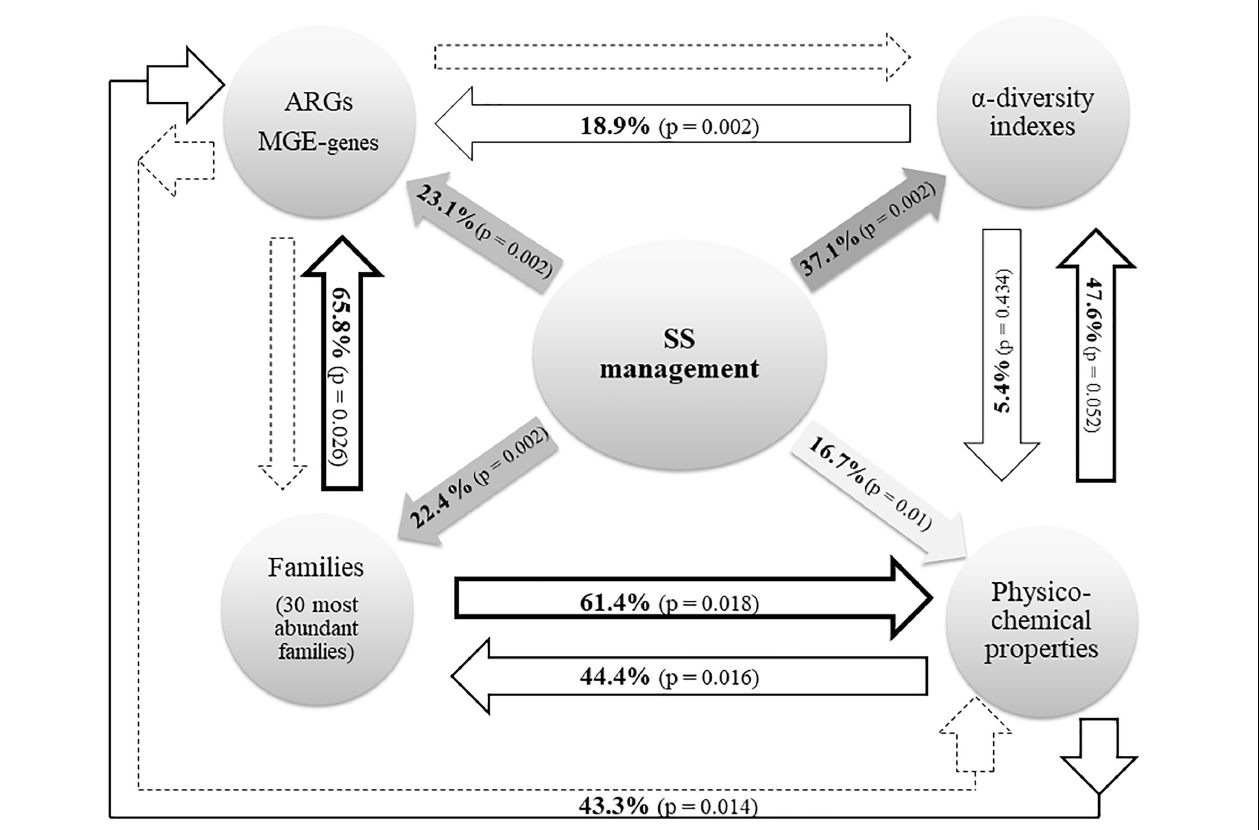
FIGURE 2 | Radial diagram from RDA data. Solid lines represent a significant ( p < 0.05) effect of the corresponding variable. Dotted lines represent the lack of significant effect. The variable “SS management” includes the dosage of application, the elapsed time after the last application, and the presence/absence of SS. ARGs and MGE-genes: relative abundance (relative to the 16S rRNA gene) of ARGs and MGE-genes. α -diversity: richness, Shannon’s diversity and Simpson’s diversity. Physicochemical properties: OM, pH, CEC, EC, NO3 − , NH4 + , total N, Olsen P, K + , texture, and pseudo-total metal concentrations (Cd, Cr, Cu, Ni, Pb, and